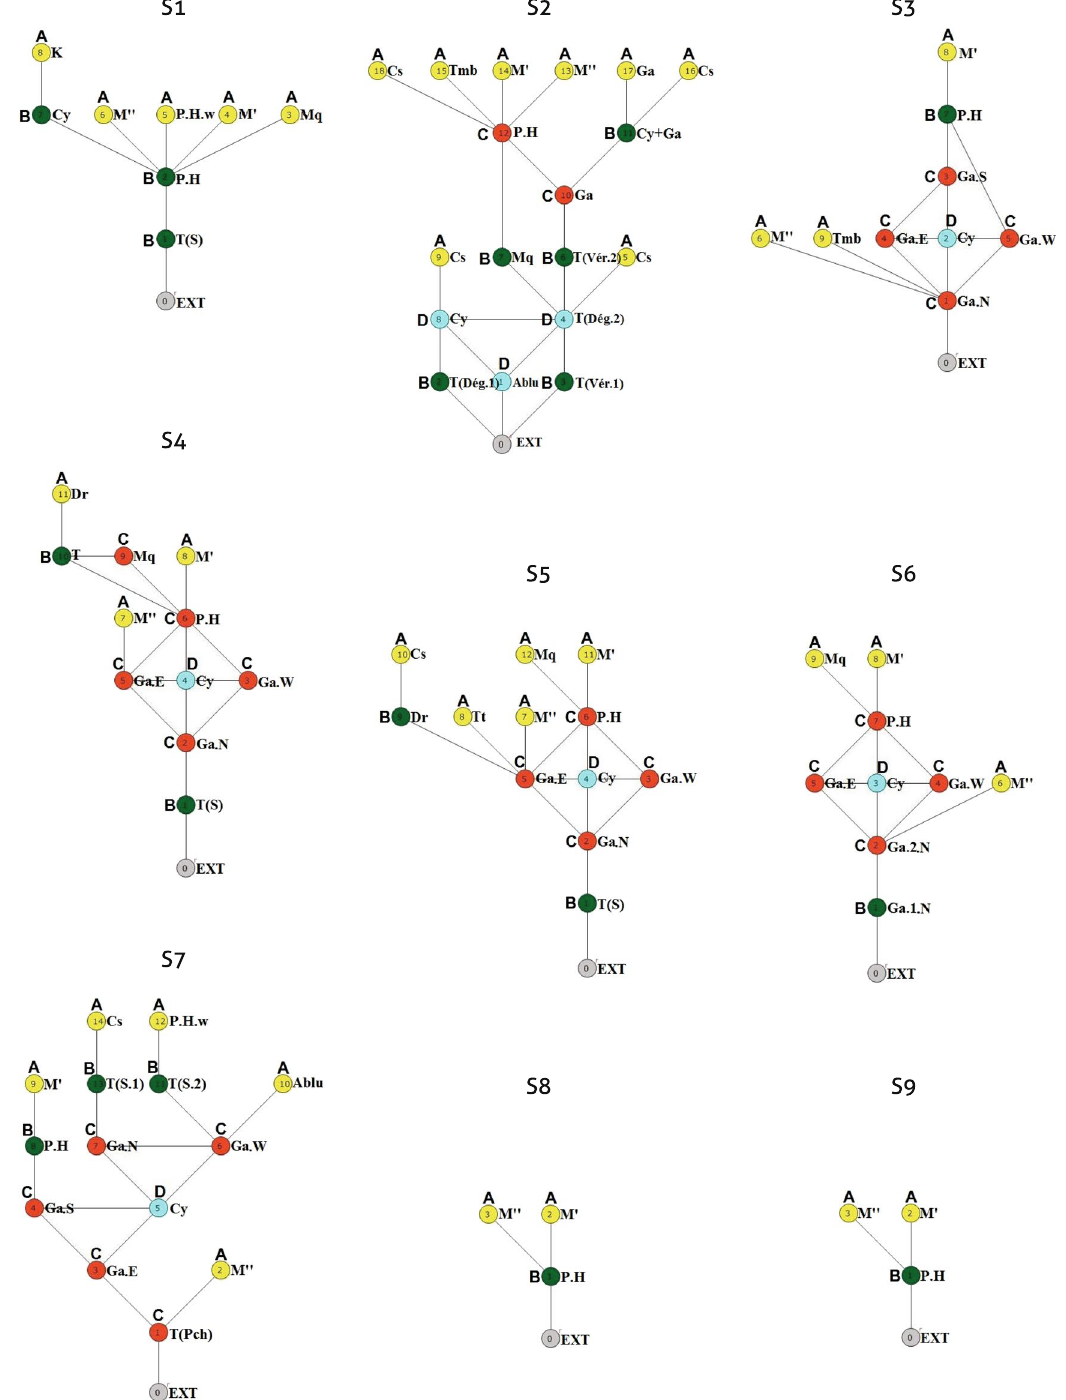
Fig. 5 Justified graphs with labelling of spaces and visual characterisation: S1–S9 (Source: the